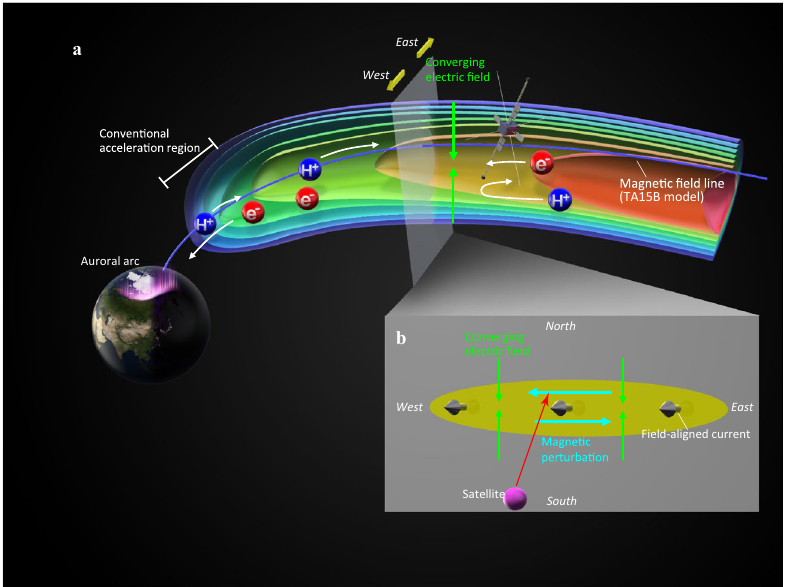
Figure 4. Schematic of the very high altitude electron acceleration powering an auroral arc. ( a ) Illustration in the meridional plane. ( b ) Illustration in the plane perpendicular to the background magnetic